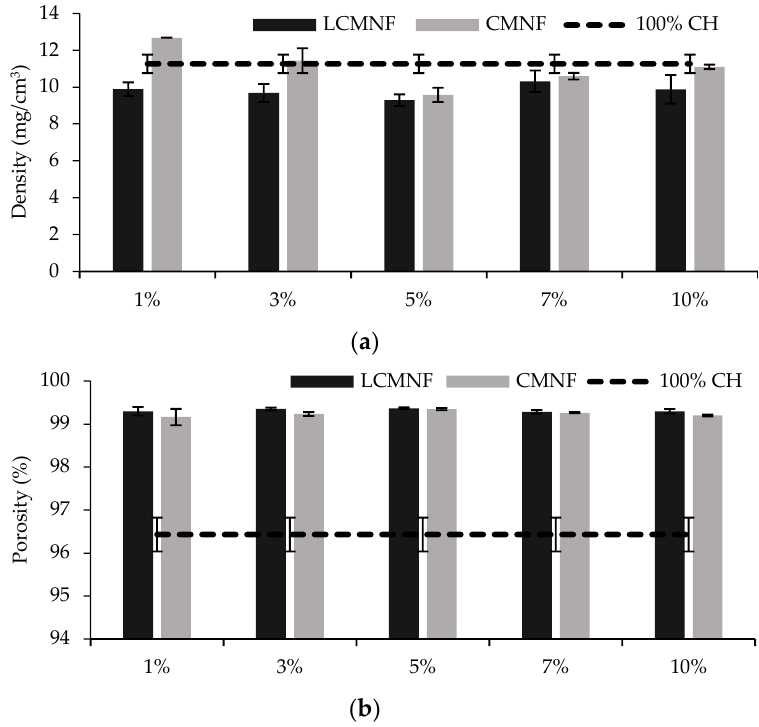
Figure 1. ( a ) Density and ( b ) porosity of the reinforced CH aerogels. To find out the reaction mechanisms between the functional groups of LCMNF-CH and CMNF-CH aerogels, FTIR and XRD analyses were performed (Figure S3). However,